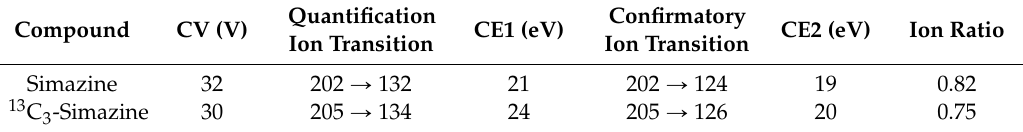
Table 3. Tandem mass spectrometry parameters used for analysis of